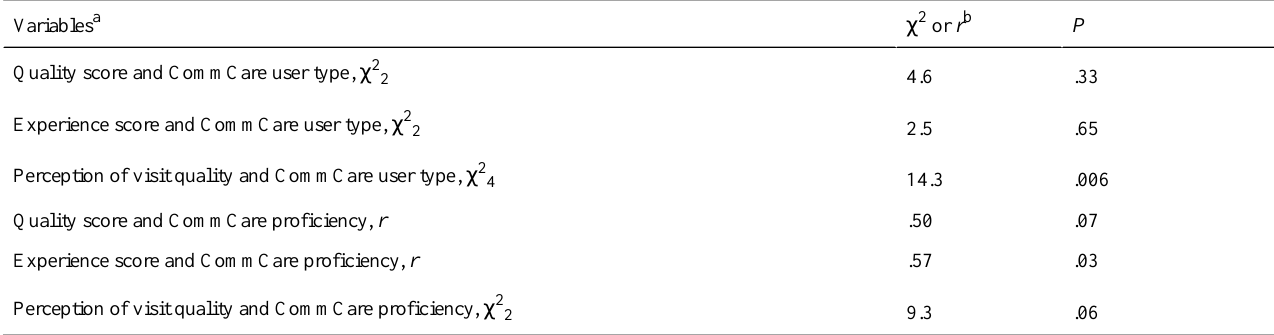
Table 6. Correlations between CommCare adoption and quality and experience of